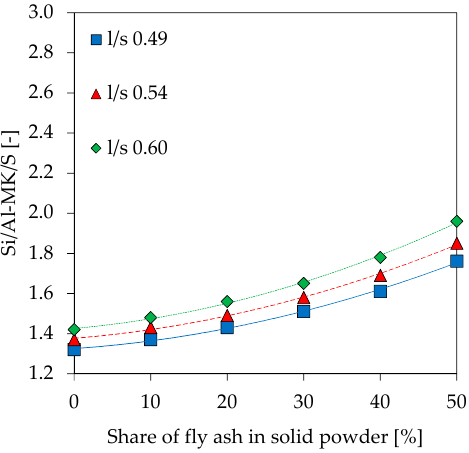
Figure 15. Theoretical Si/Al ratio, calculated with amorphous Si and Al, without fly ash (Si/Al-MK/S).